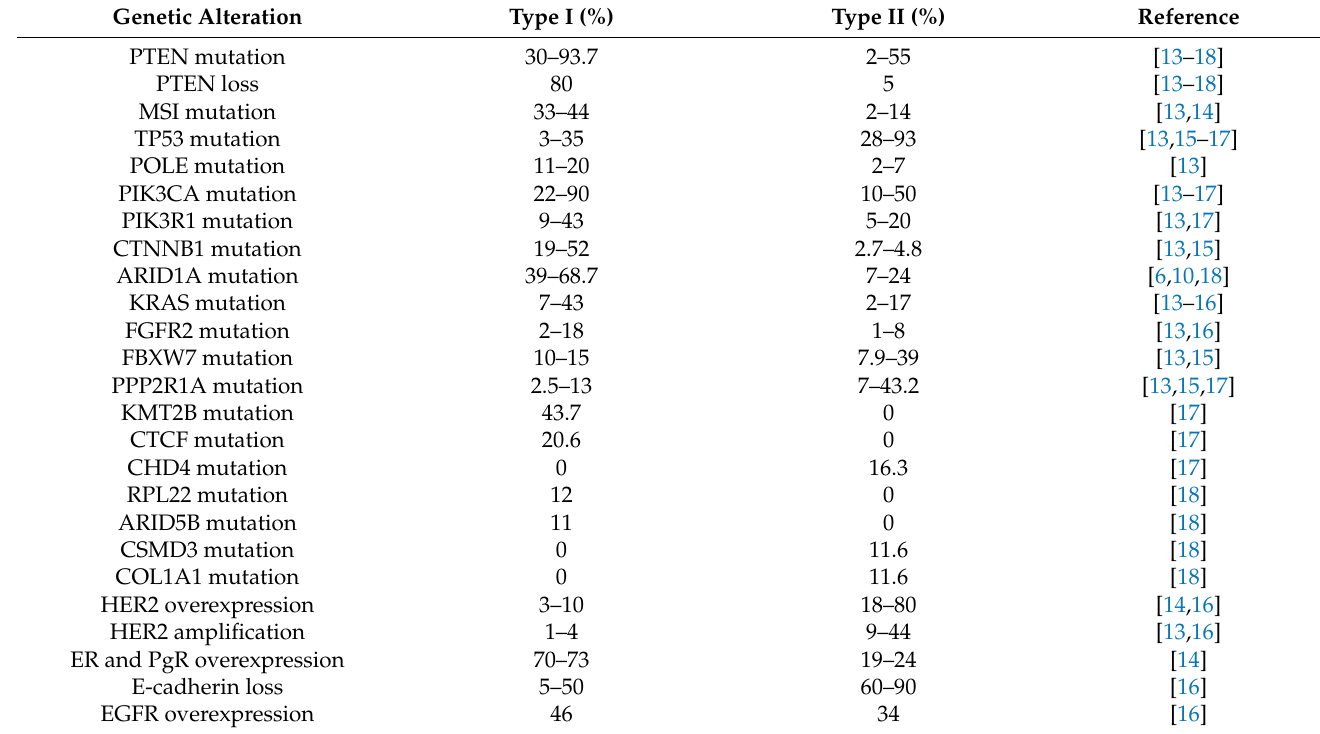
Table 1. Common genetic/molecular alterations and frequencies in type I and type II